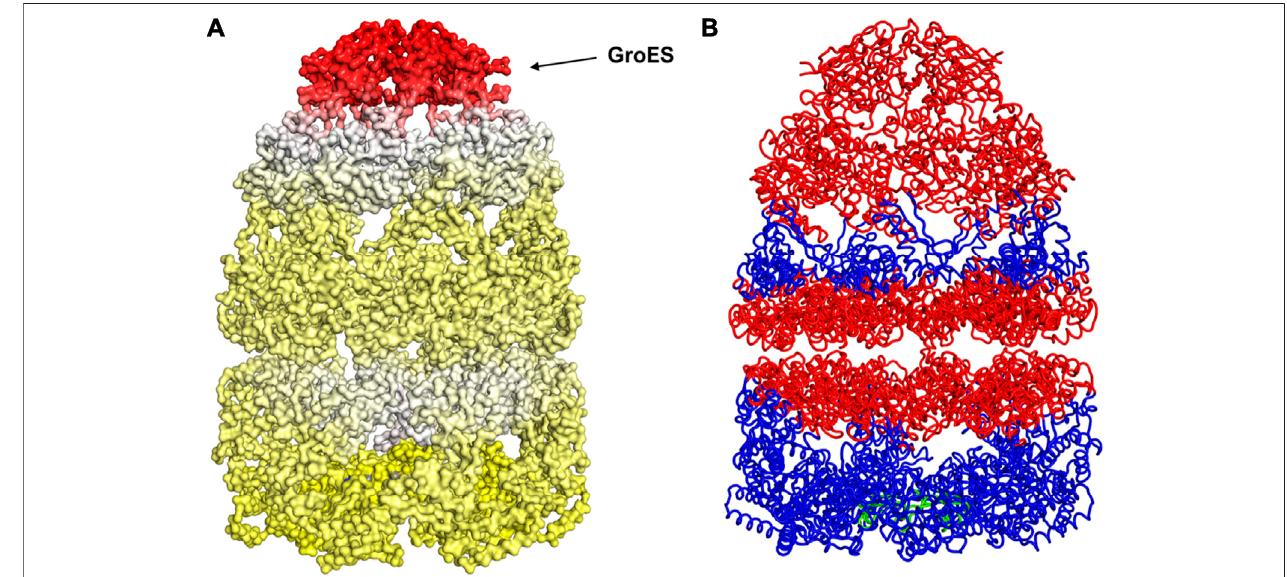
FIGURE 5 | Mechanism for release of GroES (and internal peptide). Change in fl uctuations in the Groel-GroES assemblage upon peptide binding. (A) Gains of fl uctuationsare scaledbetween 0 (white) and 1 (red), and lossof fl uctuationsshown alsobutseparately between 0 (yellow)and − 1 (blue), (B) Increased (red) and decreased (blue) fl uctuations upon peptide binding is shown. This suggests that peptide binding to the lower ring causes release of GroES and internal peptide from the upper